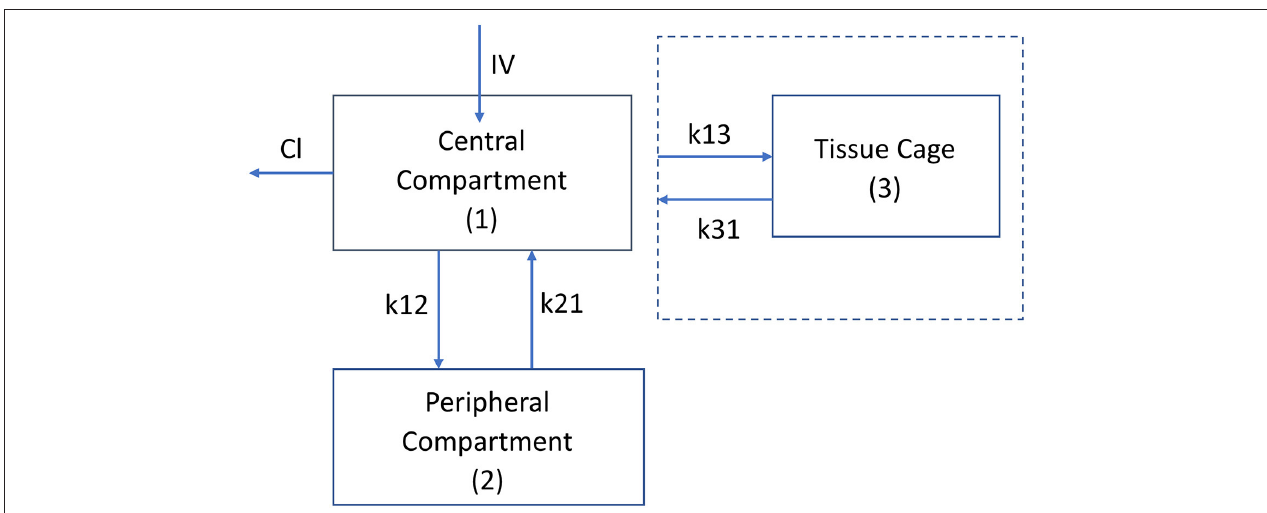
FIGURE 1 | Schematic diagram of the pharmacokinetic model, plasma kinetics are model with a 2 compartment model with intravenous (instantaneous) administration into the central compartment ( 1). Clearance is from the central compartment. k12 and k21 are the rate constants (h − 1 ) for the drug movement from the central compartment (1) to the peripheral compartment (2) and from the peripheral compartment to the central compartment, respectively. The kinetics of the tissue cage compartment are driven by the central compartment concentration with no change in the central compartment concentration. The drug’s movement into and out of the cage is modeled by the rate constants k13 and k31, respectively. The volume of the tissue cage compartment is specified by the size of the tissue cage ( Table 1 ).